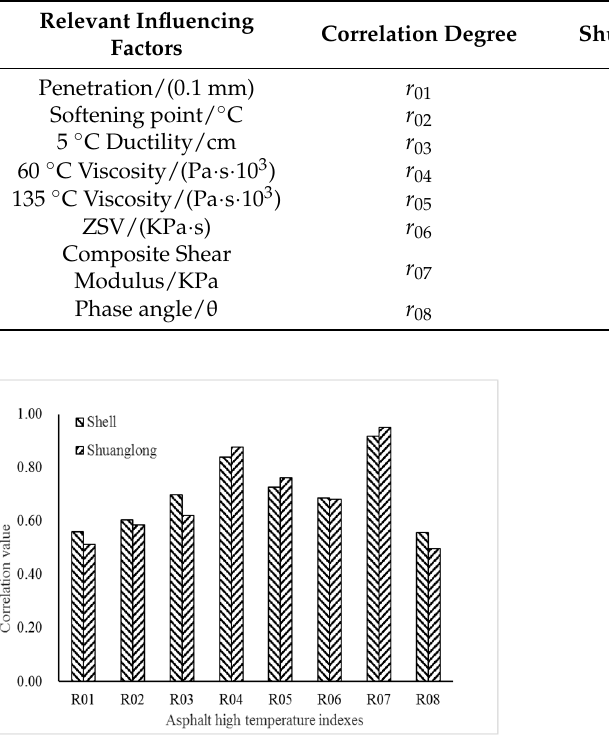
Figure 10. Gray correlation analysis results of anti-rutting and the other properties.